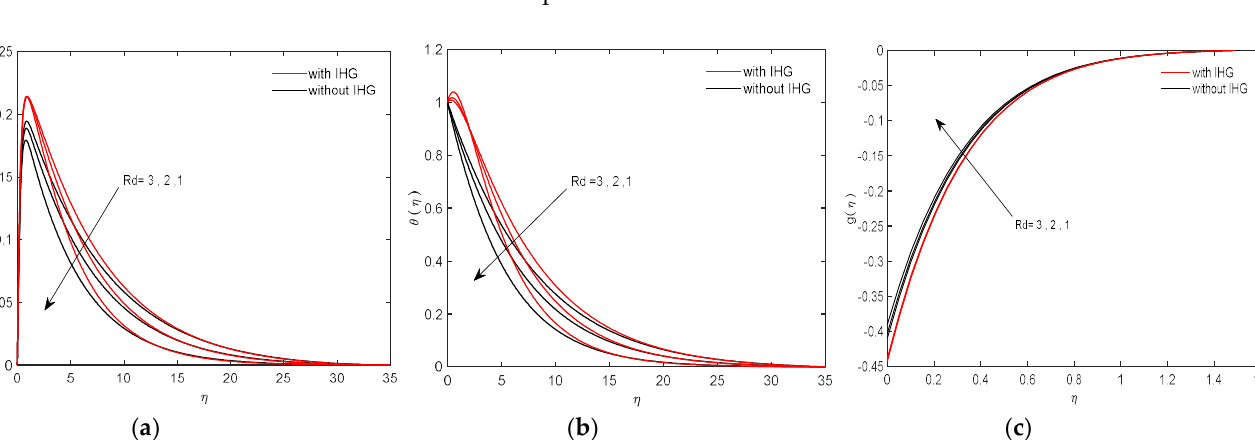
Figure 7. The effect of the micro-rotation parameter (cid:1866) on the ( a ) velocity profile, ( b ) temperature profile and ( c ) angular velocity profile for (cid:1844) = 0.5,(cid:1839) = 2,  = 0.5,(cid:1855) = 0,(cid:1828) = 0.2,(cid:2004) (cid:2869) = (cid:2038) (cid:2870) = 0.05,(cid:1830)(cid:1853) = 1, (cid:1844)(cid:1856) = 1, (cid:1858) (cid:3050) = 0.5 .